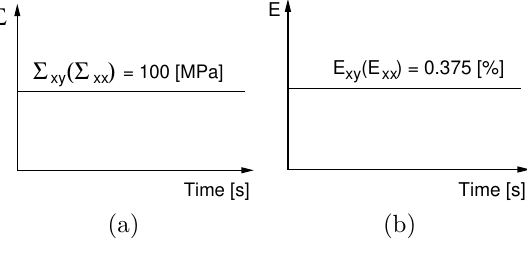
Figure 3. Periodic unit cells: a) PHA model, b) basalt 5 fiber UC, c) basalt 10 fiber UC.